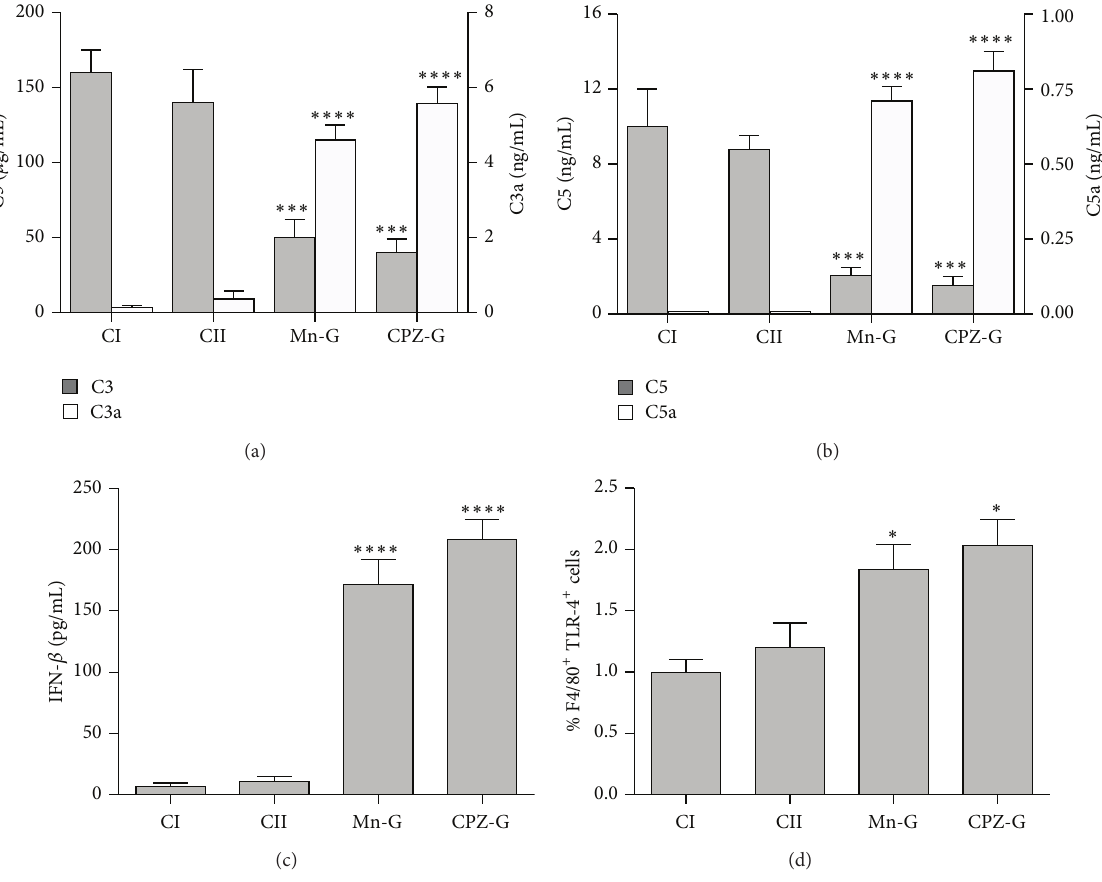
Figure 5: C3, C5, TLR-4, and IFN- 𝛽 are overexpressed in the spleens of mice with a disease resembling human lupus. The complement proteins C3 and C5 (a), the fragments C3a and C5a (b) (produced by C3 and C5 cleavage), and IFN- 𝛽 (c) were detected in a cell-free extract from the spleen of mice injected with TS buffer, Control I group (CI), egg-yolk phosphatidylcholine/egg-yolk phosphatidic acid (50 nmol phosphatidic acid in 50 𝜇 L TS) liposomes alone, Control II group (CII), or bearing Mn 2+ -induced nonbilayer phospholipid arrangements (Mn-G) or chlorpromazine-induced nonbilayer phospholipid arrangements (CPZ-G). The detection ranges were C3 (4.69–300 𝜇 g/mL), C3a (0.16–10ng/mL), C5 (0.25–16 ng/mL), C5a (0.062–4.0 ng/mL), and IFN- 𝛽 (7.8–500 pg/mL). TLR-4 (d) was detected by flow cytometry on cells obtained from fresh spleens from the four treatment groups. Bars represent the mean ± SD of three independent experiments, with